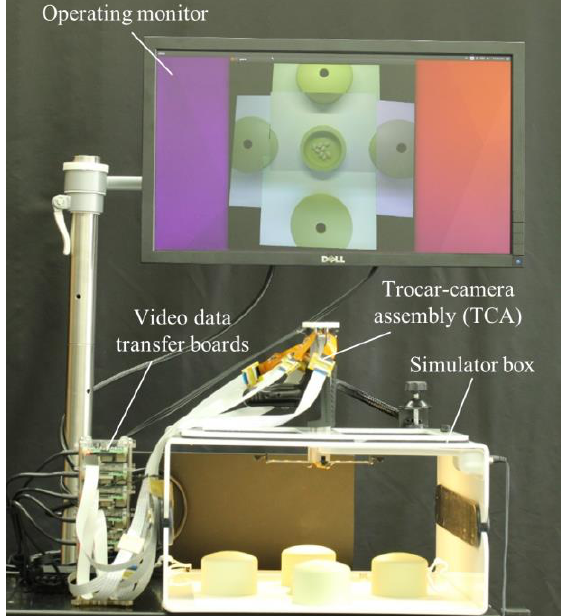
Figure 3. Demonstration setup. The TCA is inserted into the simulator box. Video data from